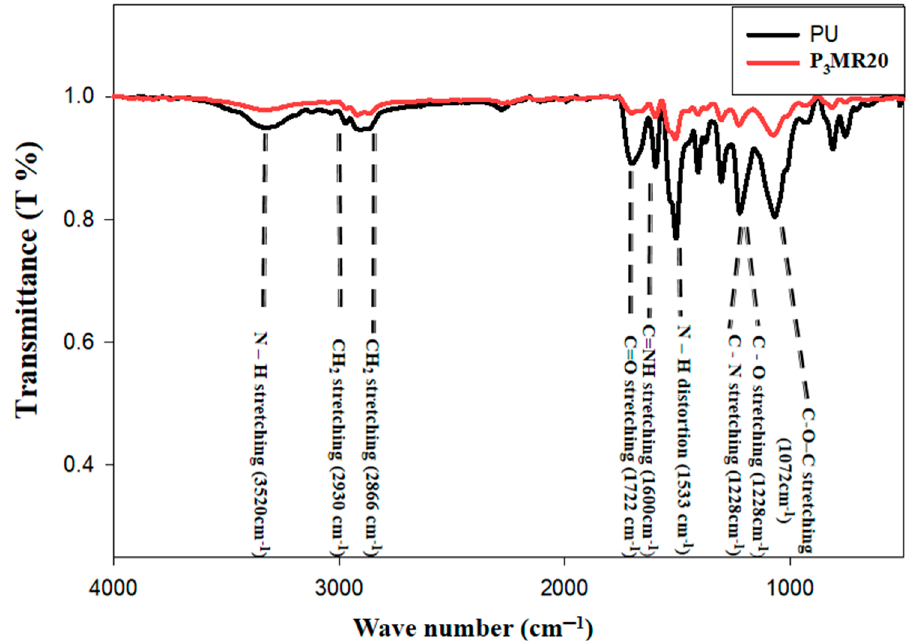
Figure 6. The FTIR spectra for PU and P 3 MR20.